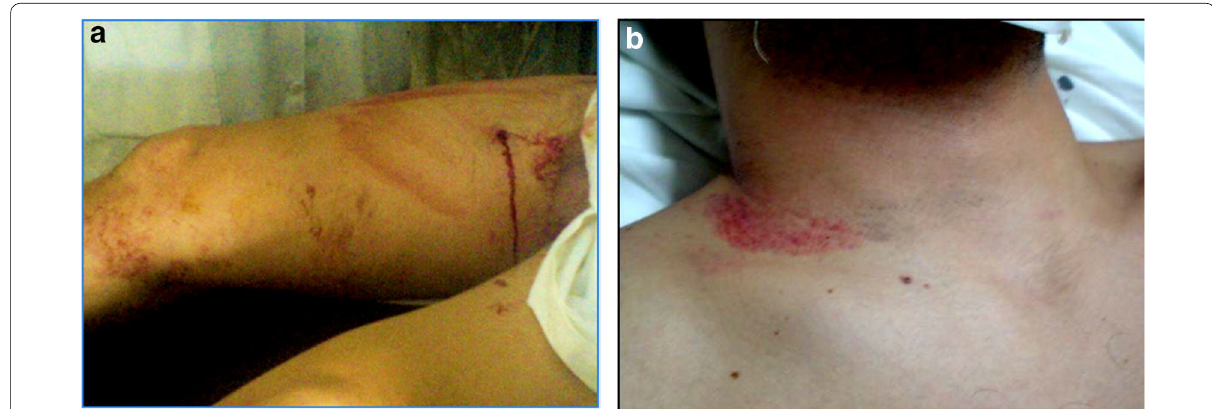
Fig. 1 a Penetrating wound in the leg: gun shot wound. b Blunt trauma of the